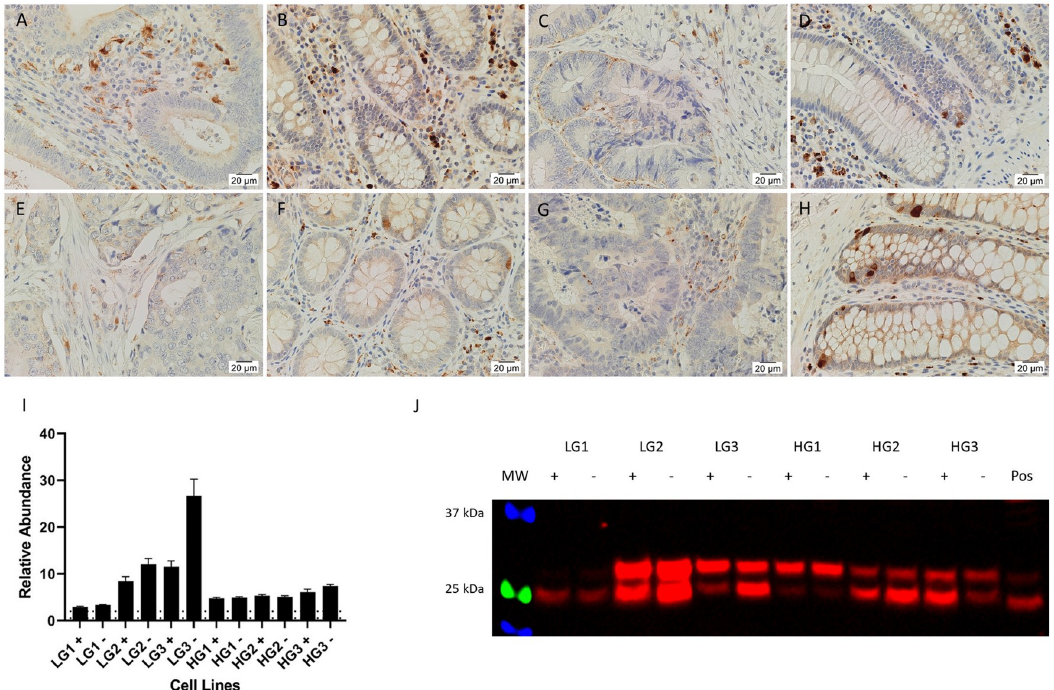
Fig 4. Expression of cathepsin B. Representative IHC stained images of CTSB, including 2 LGCA samples (A, C) and their patient- match NC tissues (B, D), and 2 HGCA samples (E, G) and their patient-matched NC tissues (F, H). Nuclei were counterstained with hematoxylin (A-H, blue); original magnification: 400x. CTSB mRNA expression levels were measured by RT-qPCR (I) in 3 LGCA and 3 HGCA primary cell lines that were sorted into EpCAM High (+) and EpCAM Low (-) subpopulations, and the average mRNA abundance from triplicate values relative to a pool of NC tissues are displayed with error bars representing standard deviation. CTSB protein expression by cell lines was detected by WB (J; 24 kDa and 27 kDa); positive control = HepG2 cells. Adapted from [38] under a CC BY license, with permission from Munro MJ et al .